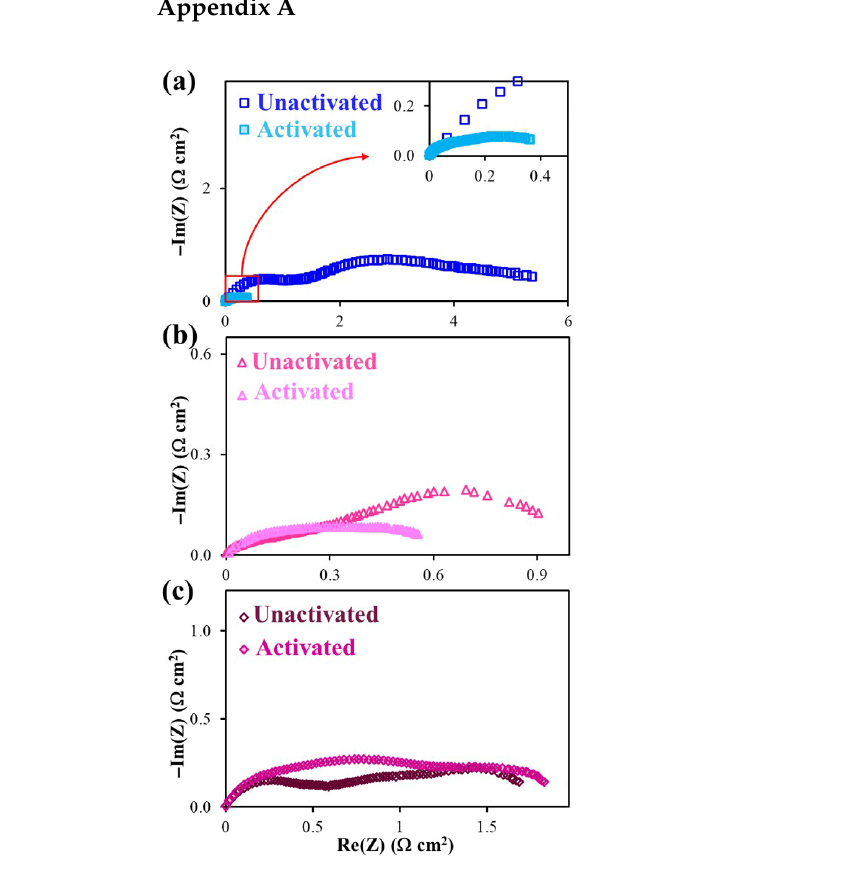
Figure A1. Nyquist coordinate impedance spectra at 600 °C obtained in SDC with BCZYF0.5 ( a ),